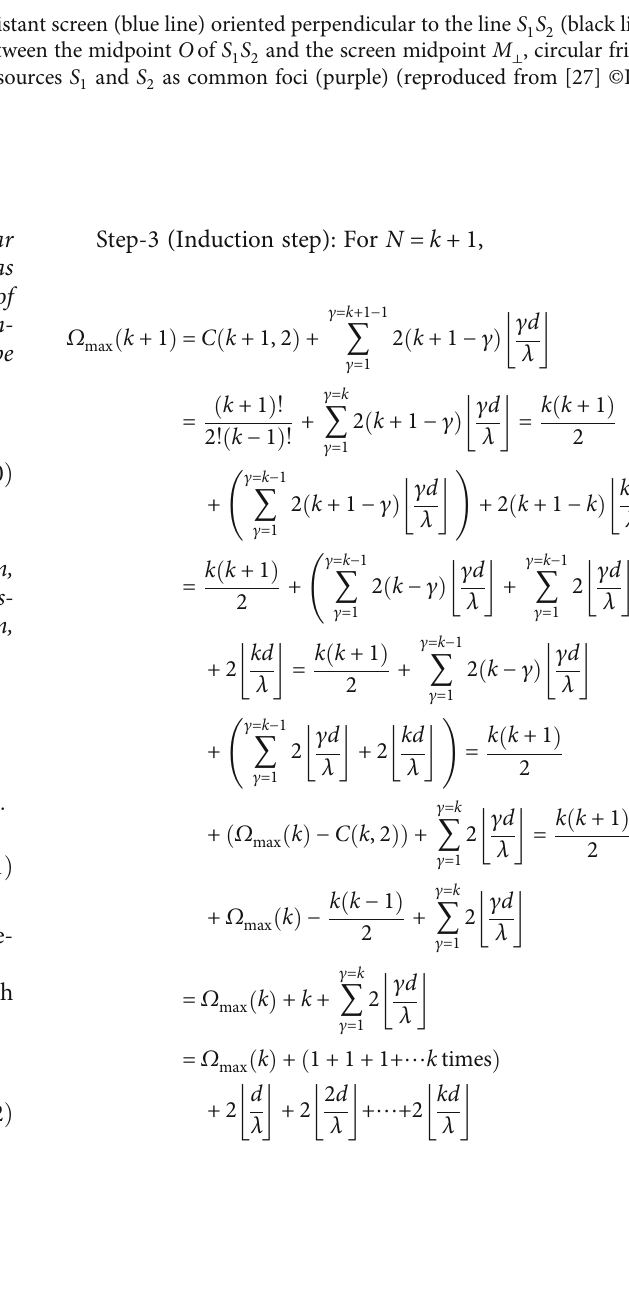
S 1 2 (black line)